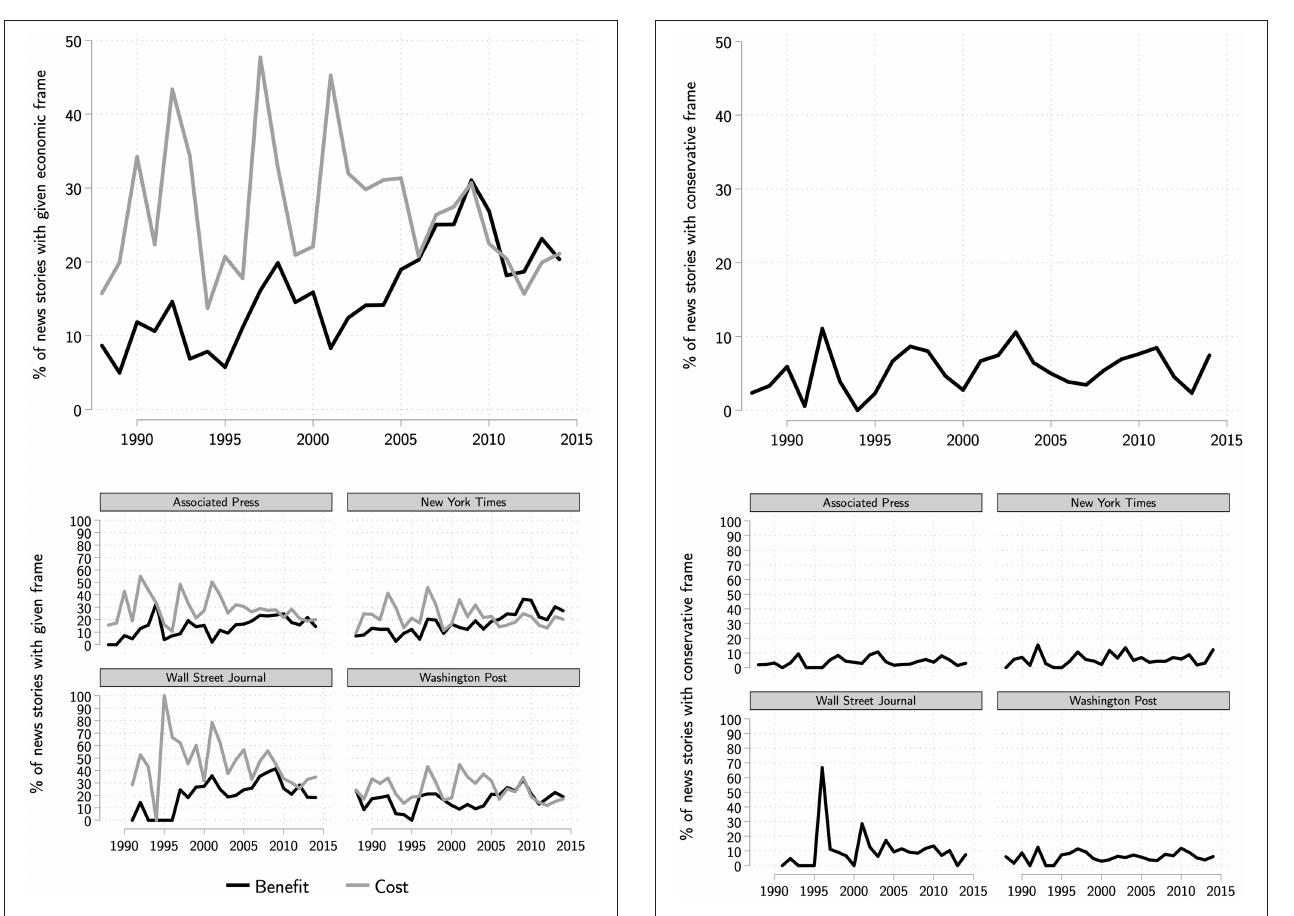
FIGURE 2 | Proportion of climate change news coverage with conservative framing from 1988 to 2014 in our combined corpus (top panel) and by source (bottom